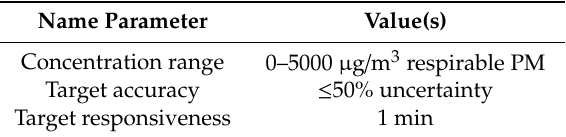
Table 1. Experimental design 1 .